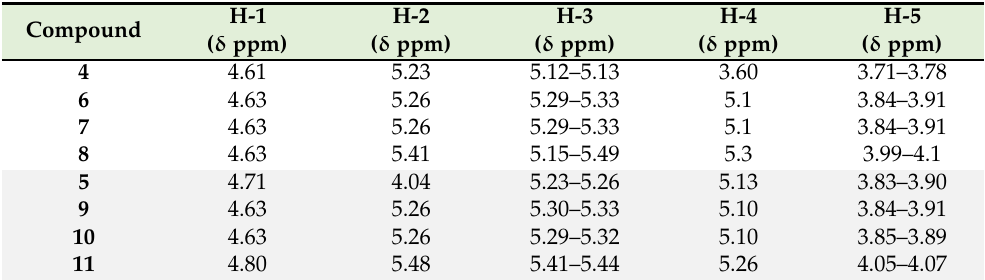
Table 1. Comparison of 1 H NMR (CDCl 3 , 400 MHz) signals for different protons in methyl 4- O -acyl- and 2- O -acyl-derivatives of 4 and 5